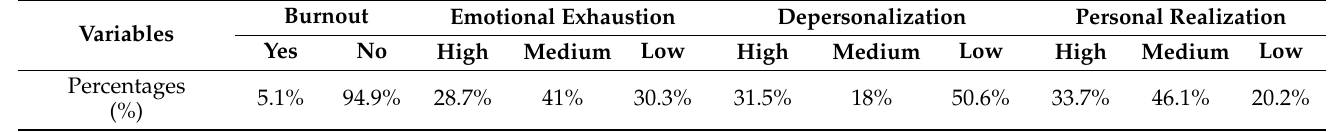
Table 2. Percentages of burnout, high emotional exhaustion, high depersonalization and low per- sonal